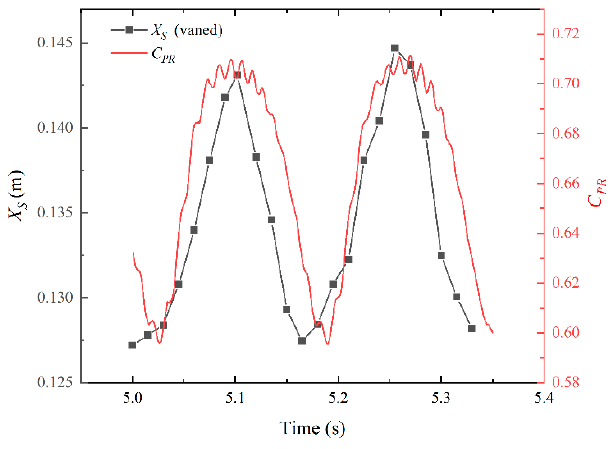
Figure 8. Variation of C PR and X S with time (vaned diffuser).